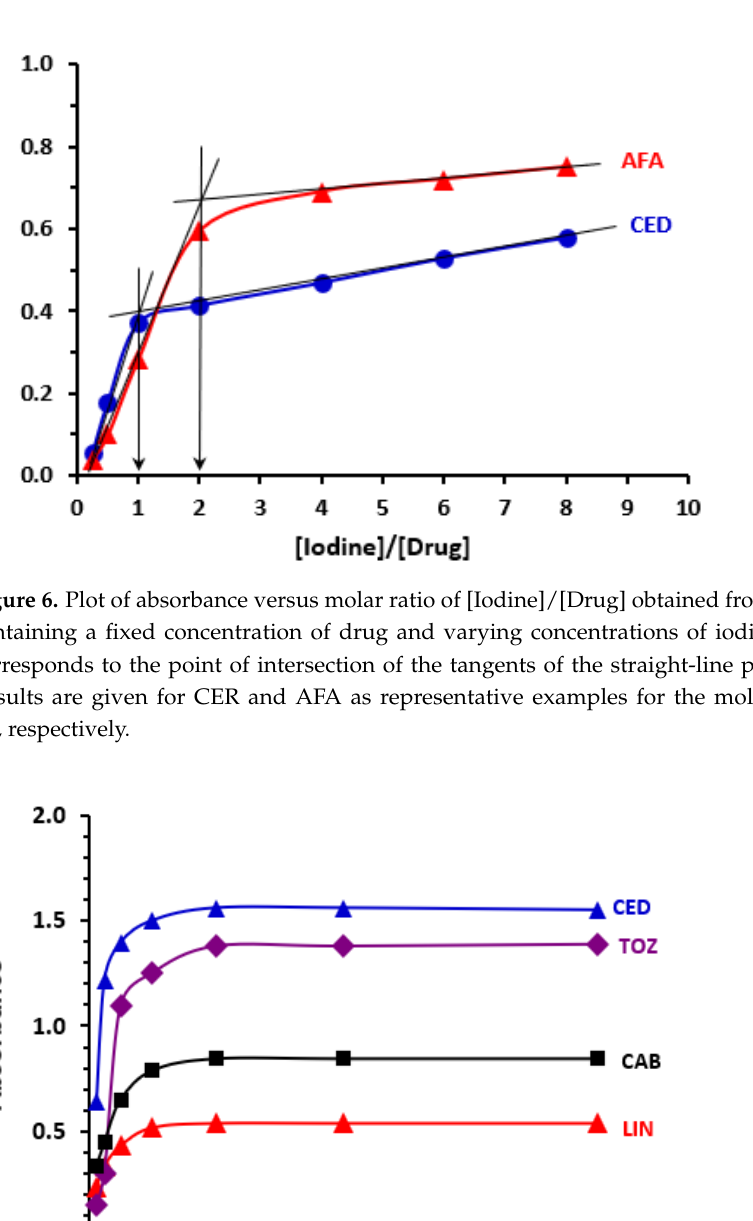
Figure 5. The association constant ( K ) versus free energy change (  G) for the CTC of TKIs with iodine. K values were presented in linear and logarithmic scale (panels ( A ) and ( B ), respectively). A value of 30 was added to all  G values to convert their negative values to positive ones.